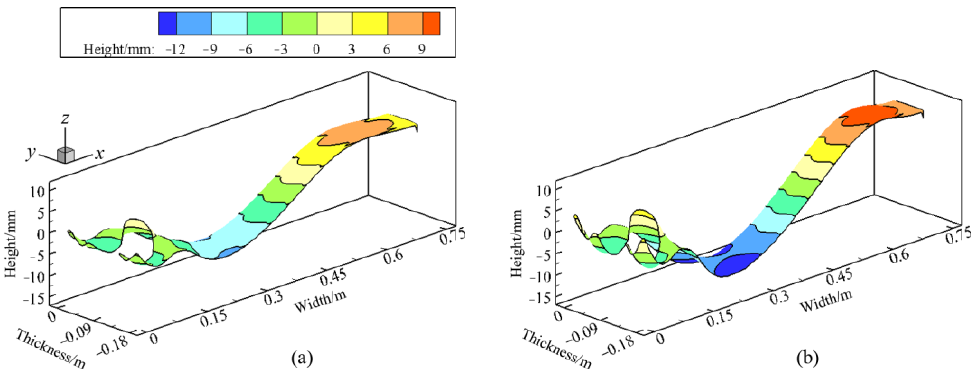
Figure 16. Effect of magnetic flux density on level fluctuation in the CSP mold: ( a ) B max = 0 T and ( b ) B max = 0.5 T.